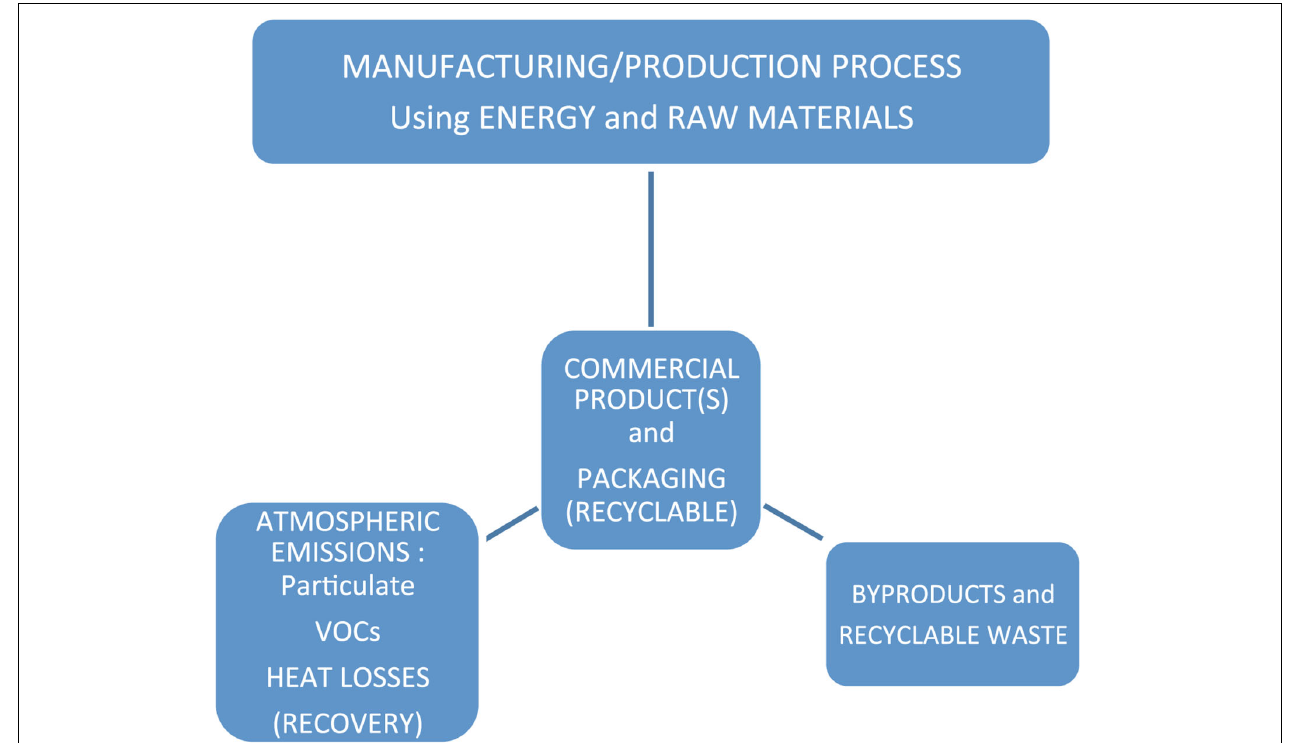
FIGURE 1 | Green process/production/manufacturing: recovery, and reuse of materials and energy and minimizing atmospheric